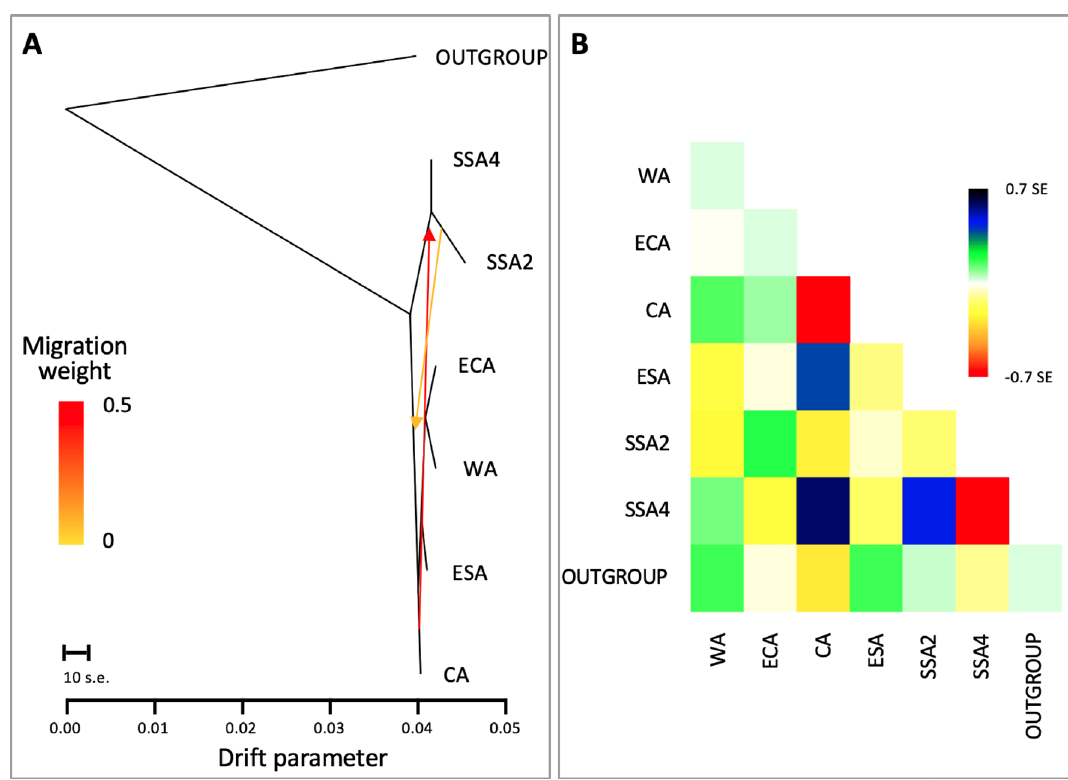
Figure 5. Gene flow between SSA species. ( A ) TreeMix ML tree with two migration edges (m = 2), showing strong gene flow from SSA1 to SSA2/SSA4 (red arrow), and weaker gene flow from SSA2 to SSA1. Clustering between ECA and WA, and between ESA and CA, provided support for their close relationships that could potentially indicate their respective putative sub-species status (i.e., SSA1-NW, SSA1-SE, respectively). Two basal branches leading to SSA1 populations (i.e., ECA, WA, ESA, CA) and SSA2/SSA4 further supported the populations analysed as consisted of two species (i.e., SSA1, SSA2). The scale bar indicates ten times the average standard error (s.e.). ( B ) The residual fit was plotted from the ML tree, which is the covariance matrix between each pair of populations. Residuals above zero are an indication of the populations most likely to be